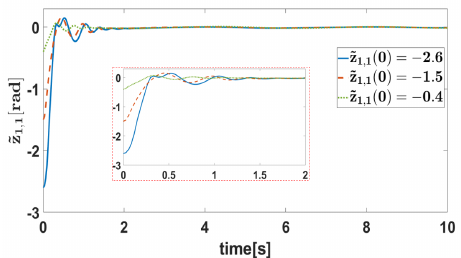
Figure 4. Error ˜ z 1,1 with different initial